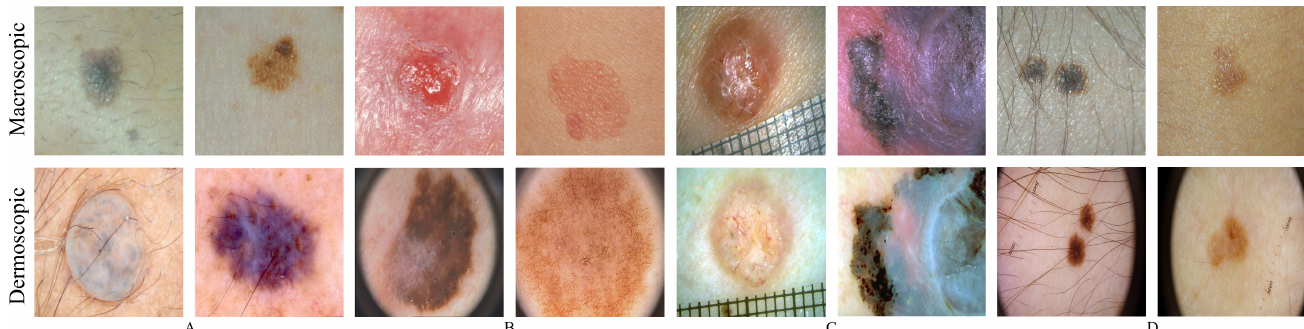
Figure 1. Illustrative examples of macroscopic (row above) and dermoscopic (below) skin lesions. ( A ) above: SMARTSKINS (Set M); below: ISIC (set D); ( B ) above: Dermofit (Set M); below: PH2 (set D); ( C ) EDRA ; ( D ) SMARTSKINS 2014/2015.